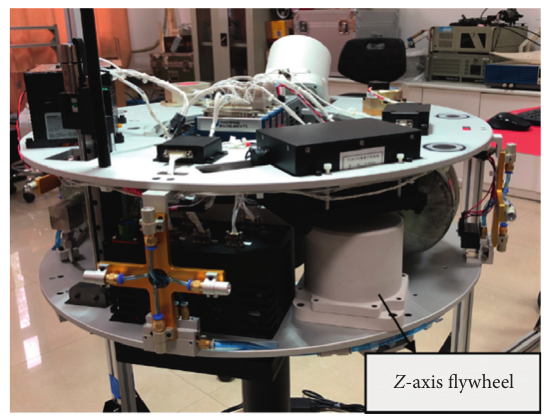
Figure 2: Z -axis reaction flywheel.